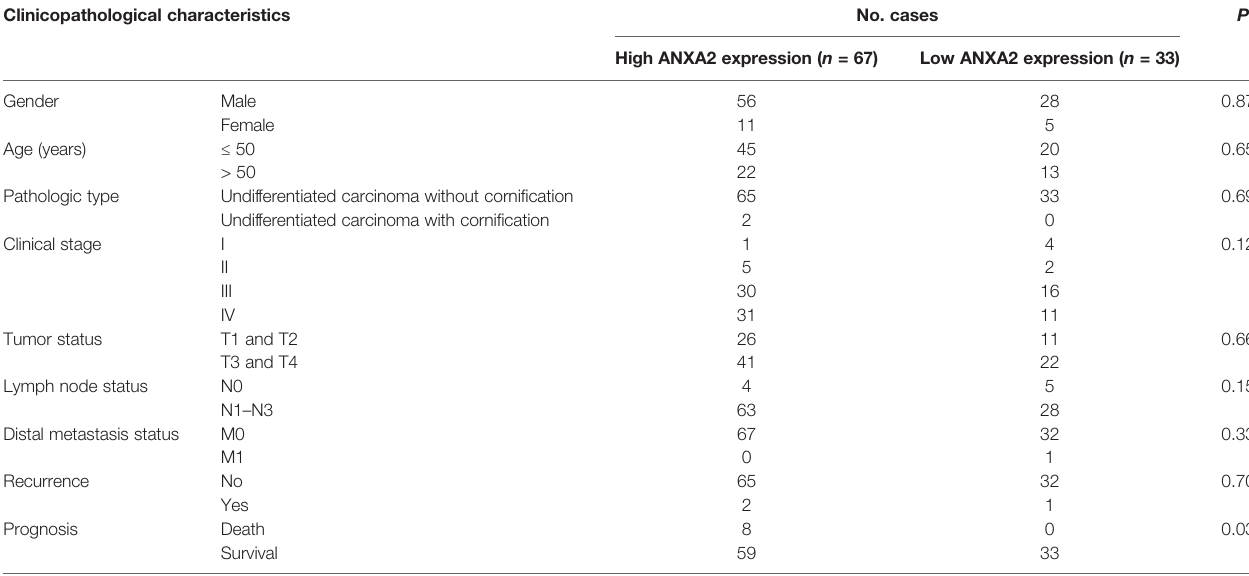
TABLE 1 | Associations of ANXA2 expression with clinicopathological characteristics in nasopharyngeal carcinoma patients. Clinicopathological